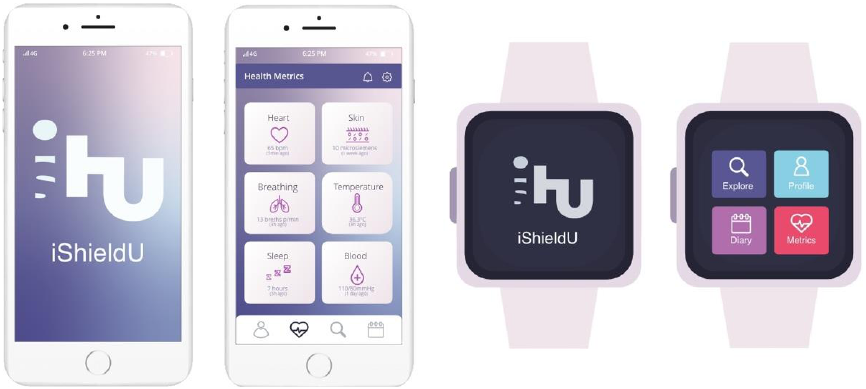
Figure 3. Smartphone app iShU landing and health metrics screen, and smartwatch app iShU landing and dashboard screen (from left to right ).